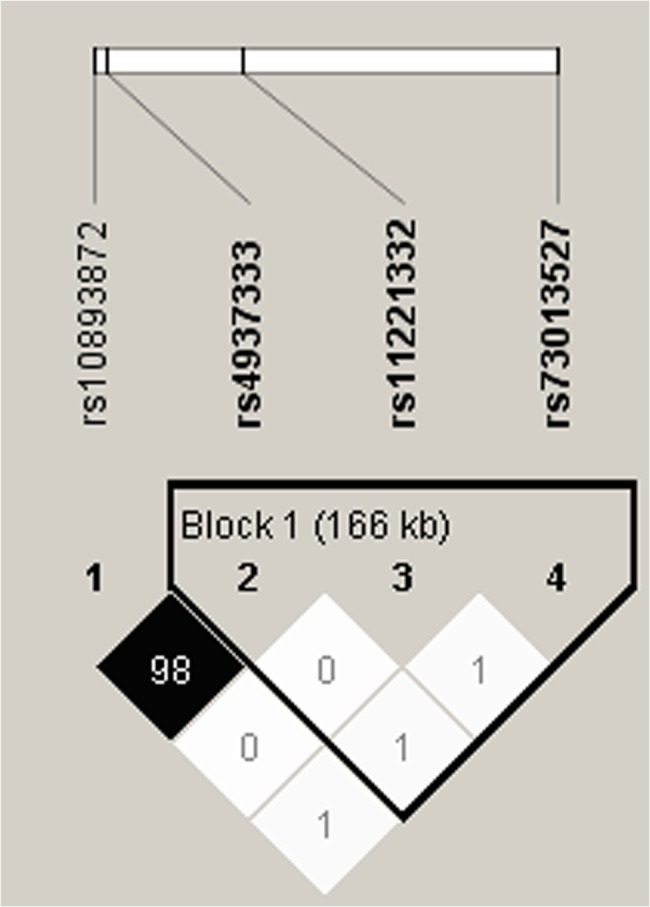
Linkage disequilibrium for four SNPs in 350 individuals.The linkage disequilibrium plot shows r² values between each pair of SNPs. rs10893872 and rs4937333 were in strong LD (black squares). D’ = 1.000, r2 = 0.980.